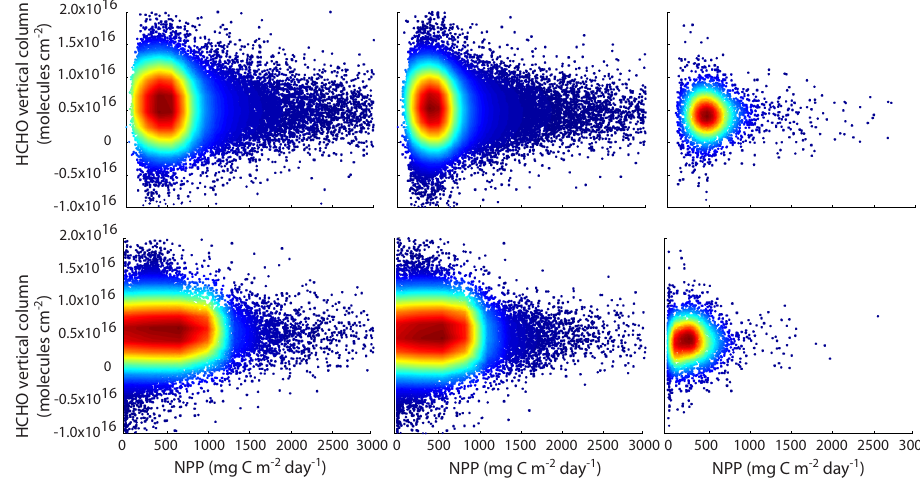
Fig. 6. Scatterplot of VGPM (top row) and CbPM (bottom row) NPP based on input from MODIS-Aqua and OMI HCHO vertical columns recalculated using updated AMF from the Mediterranean Sea subregions for 0 . 25 × 0 . 25 ◦ grids with no MODIS-Aqua AOD filter (right column), AOD < 0.2 (center column) and AOD <